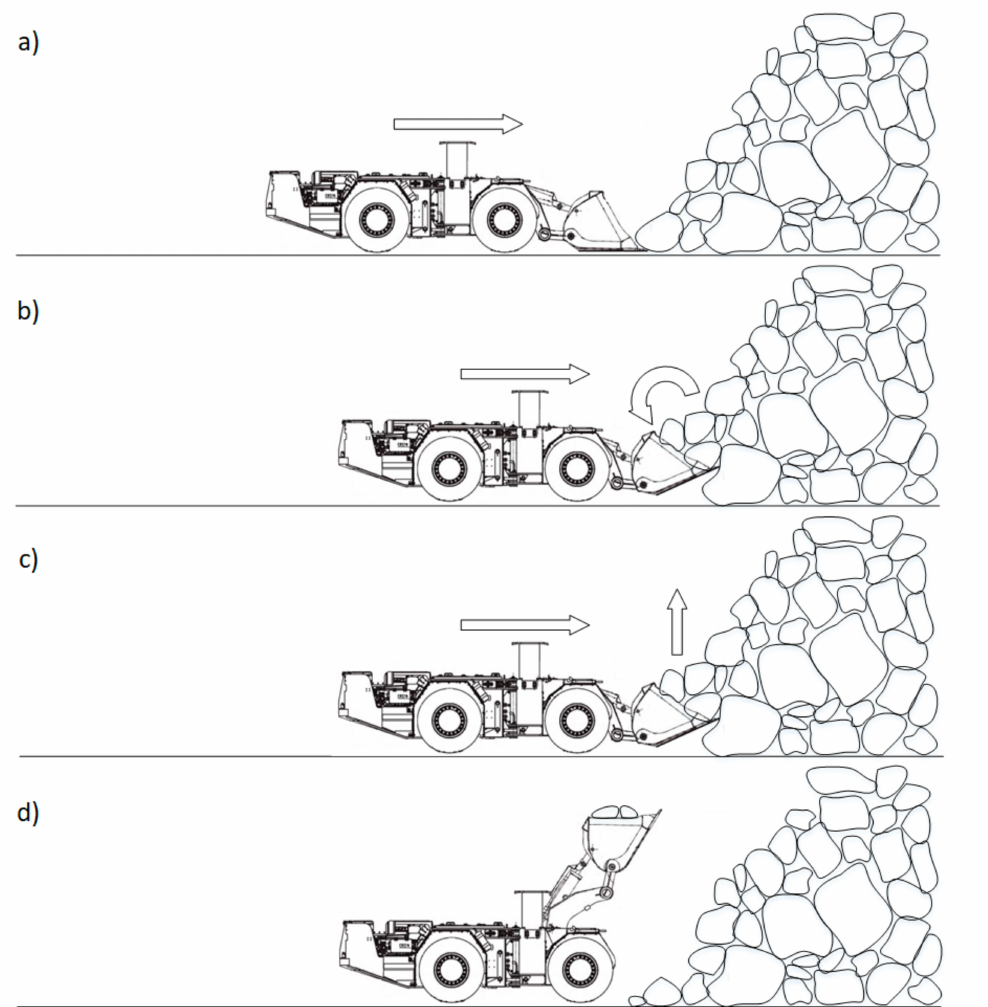
Figure 4. Excavation method diagram. ( a ) LHD engages with the rock pile. ( b ) Bucket tilt used to excavate. ( c ) Boom lift used to control wheel traction. ( d ) End of the excavation